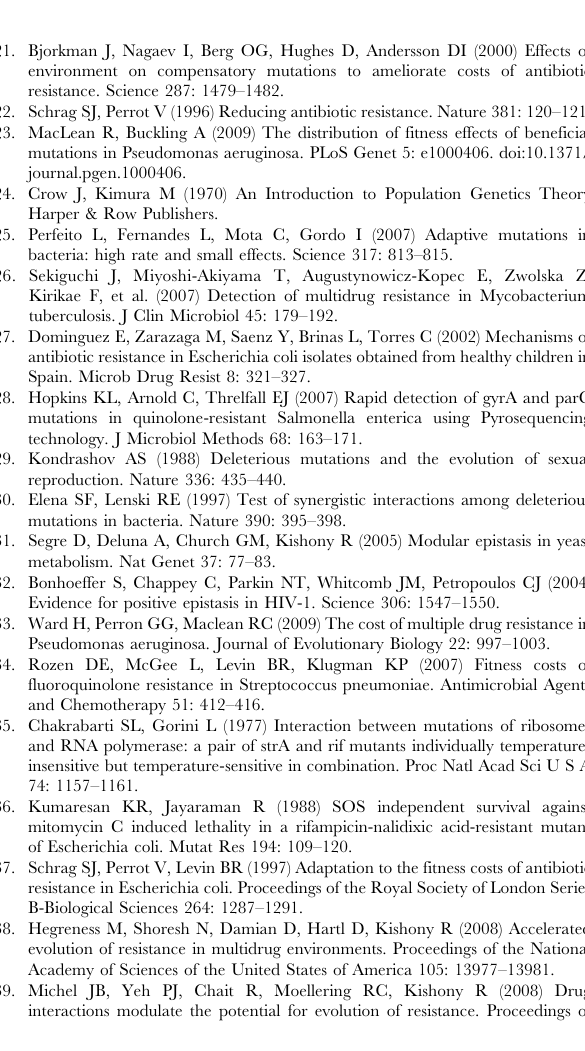
Table S2 Results of x 2 test on the effects of genetic background (wild type versus antibiotic resistant) on the spectrum of mutations that spontaneously